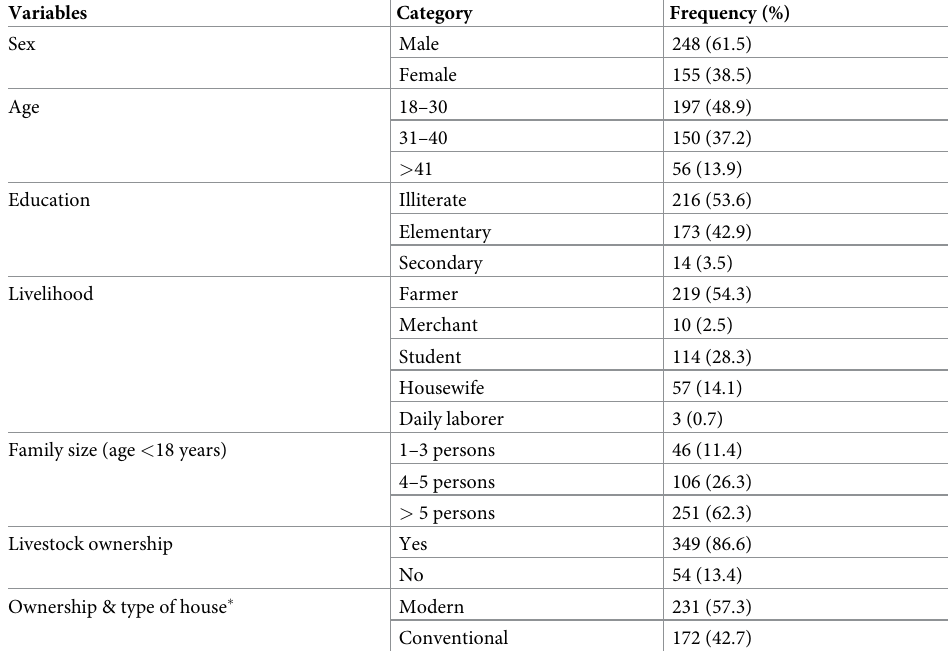
Table 1. Socio-demographic characteristics of the respondents ( N =